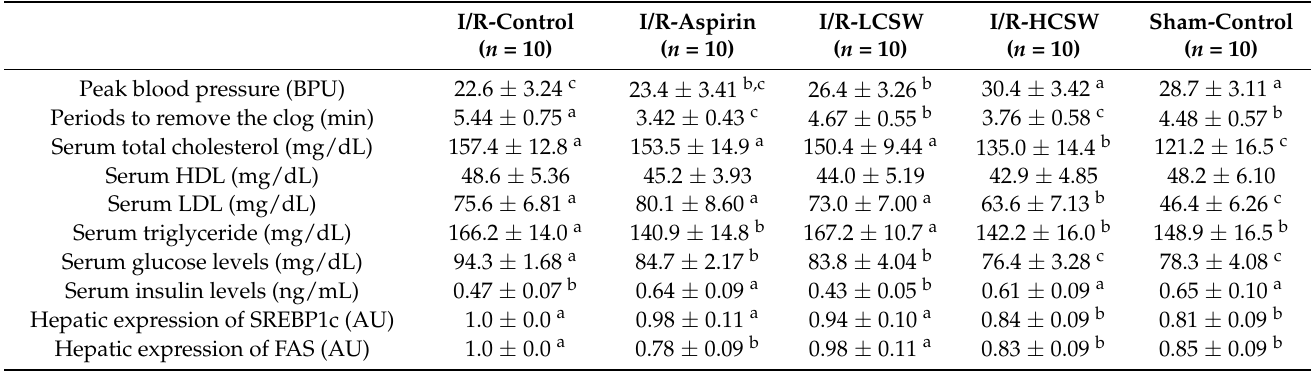
Table 2. Blood flow, serum glucose and lipid profiles, and hepatic gene expression related to fat